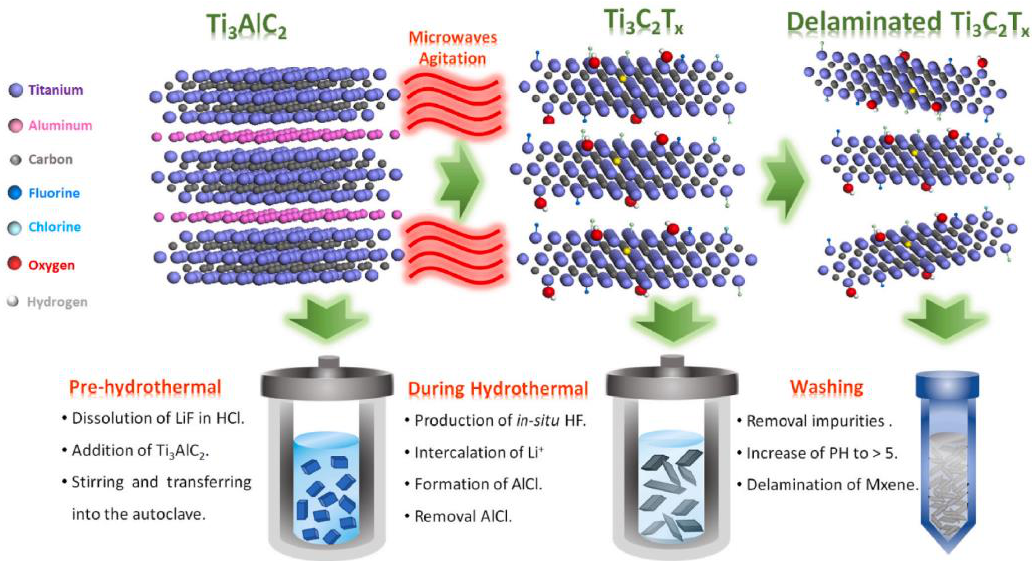
Figure 10. Schematic illustration of extraction of Ti 3 C 2 T x MXene from Ti 3 AlC 2 . Adapted with permission from [197], Copyright 2022, Elsevier.